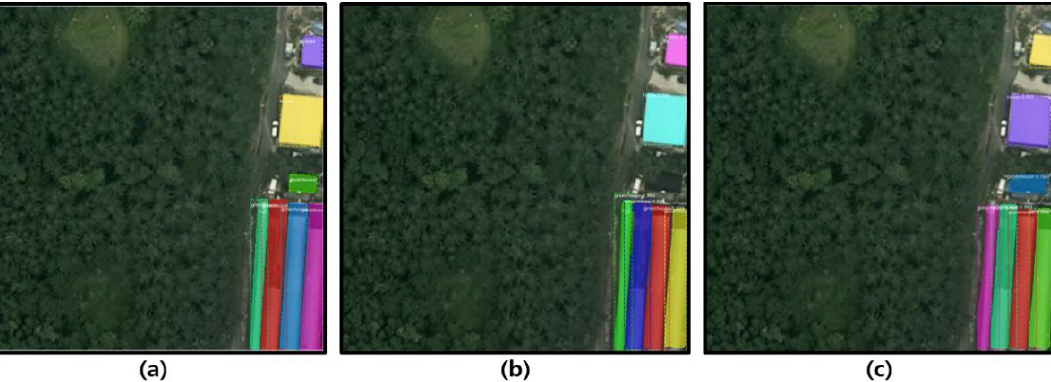
Figure 4. The model results before and after the experiment. ( a ) Annotations in the original image before the experiment. ( b ) Mask and bounding box of detected objects after applying the mask R-CNN model with hyperparameter tuning and transfer learning. ( c ) Mask and bounding box of detected objects after applying the Cascade Mask R-CNN model.